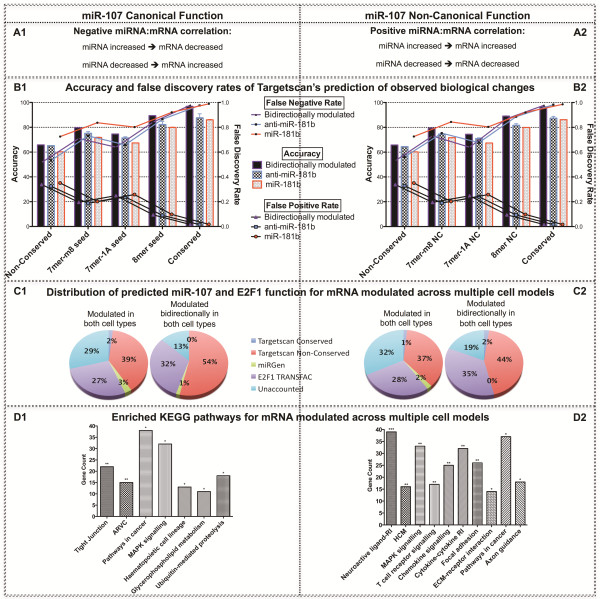
Comparison of canonical (left) and non-canonical (right) miR-107 function. Figure legend as per Figure 8 except in respect to miR-107.